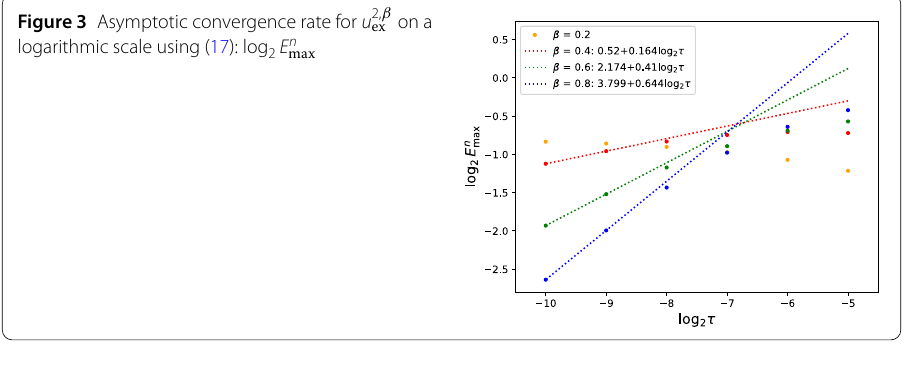
Figure 4 Convergence rate for u 2, β ex on a logarithmic scale using (17): log 2 E n